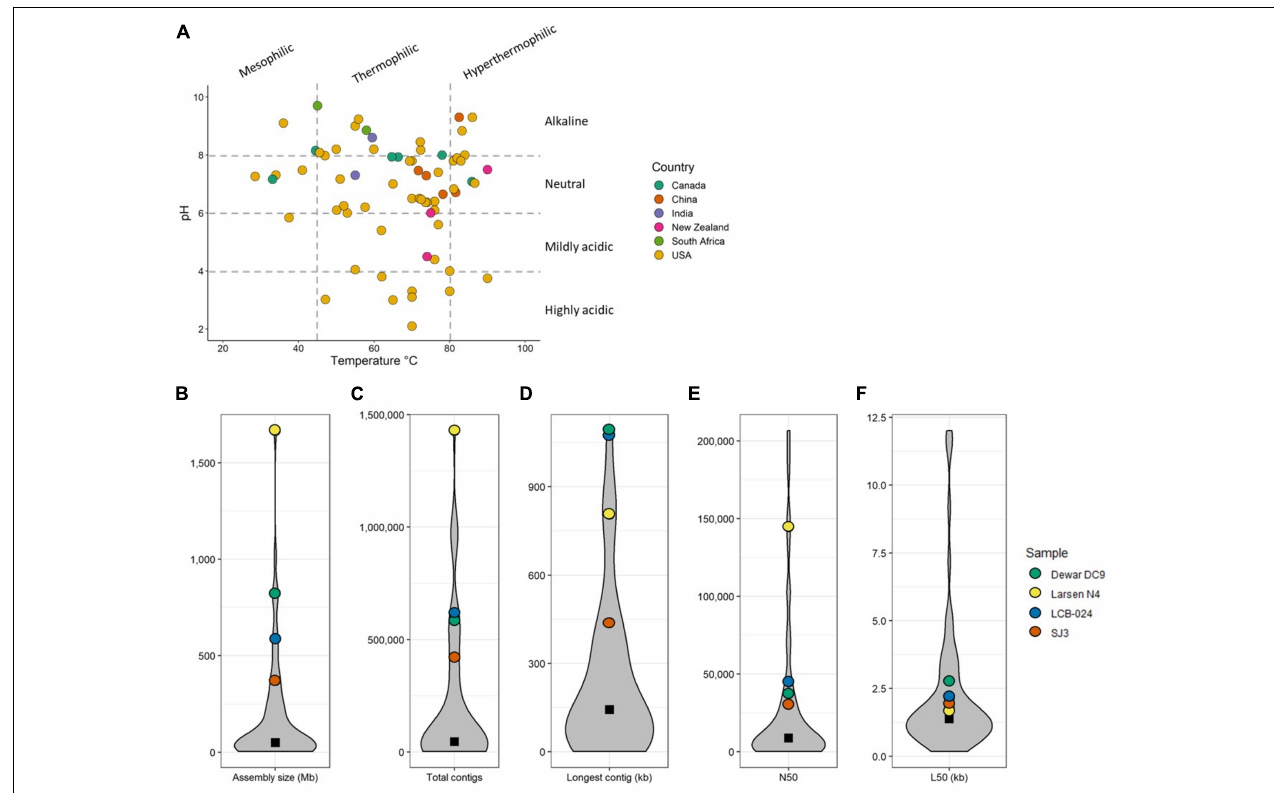
FIGURE 1 | (A) Temperature and pH scatter plot of all 71 metagenomes used in this study. Points are colored by country of sample origin. Dashed gray lines denote the temperature and pH categories used. Temperature categories: mesophilic ( < 45.0 ◦ C), thermophilic (45.0–79.9 ◦ C), and hyperthermophilic ( > 80.0 ◦ C). pH categories: highly acidic ( < 4.0), mildly acidic (4.0–5.9), neutral (6.0–7.9), and alkaline ( > 8.0). (B–F) Violin plots of sequencing statistics for all 71 metagenomes. The four metagenomes of particular interest to this study are highlighted. Black square denotes median